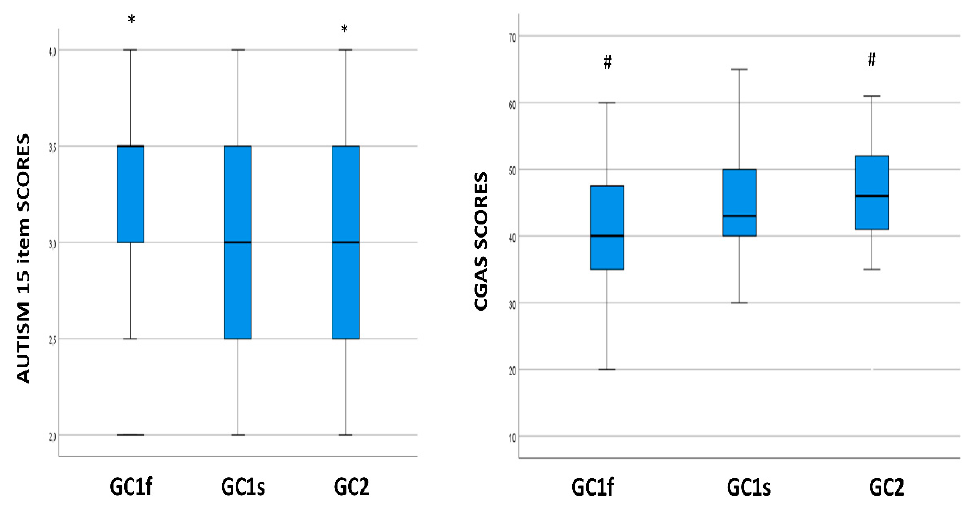
Figure 1. Boxplot of the distribution of autism 15 item and CGAS scores in relationship with the GC isoform genotypes. Within each box black lines denote median values. Statistically significant pairwise comparisons are reported: *: p = 0.014 and #: p = 0.004. CGAS: Children’s Global Assessment Scale.